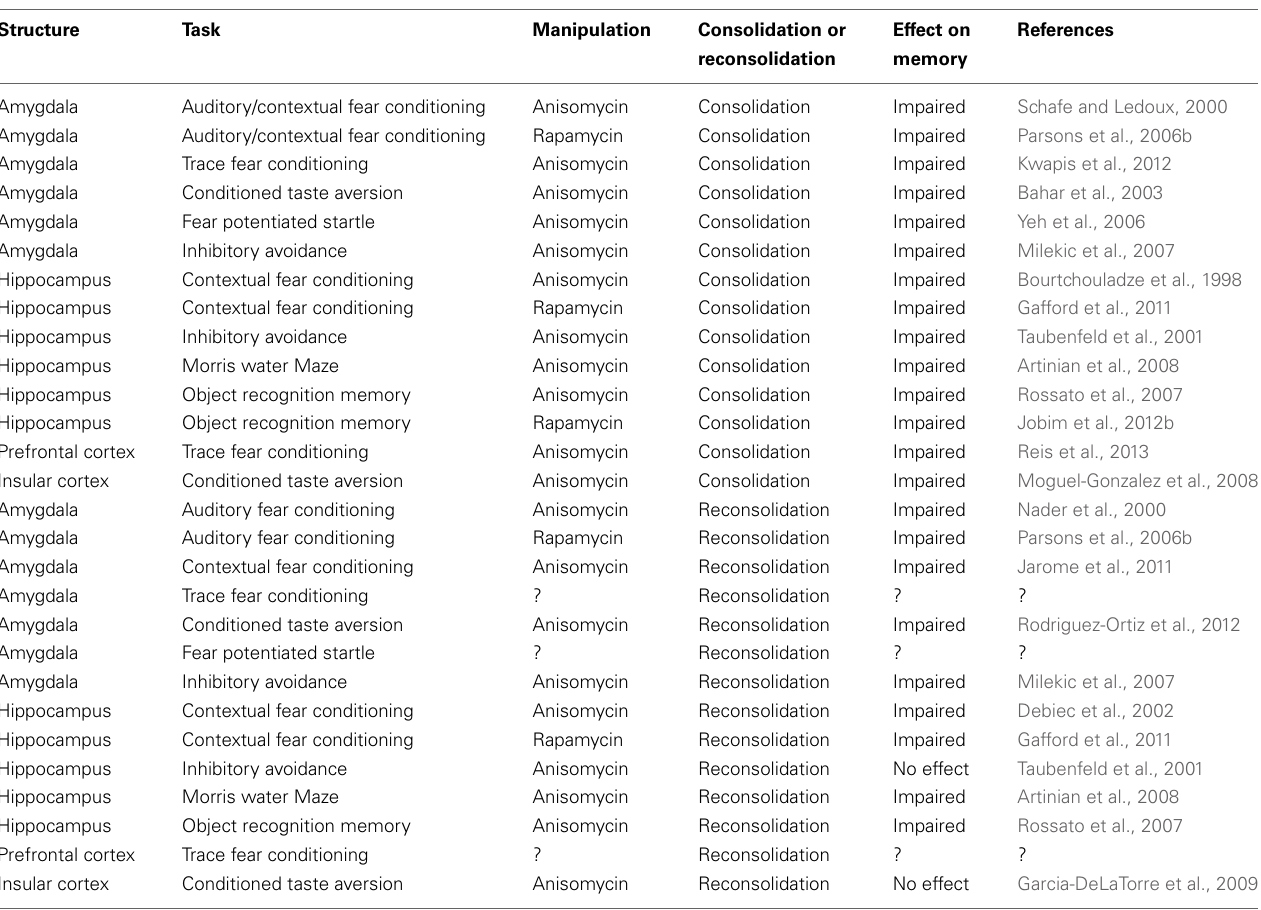
Table 1 | The role of protein synthesis in memory consolidation and reconsolidation.